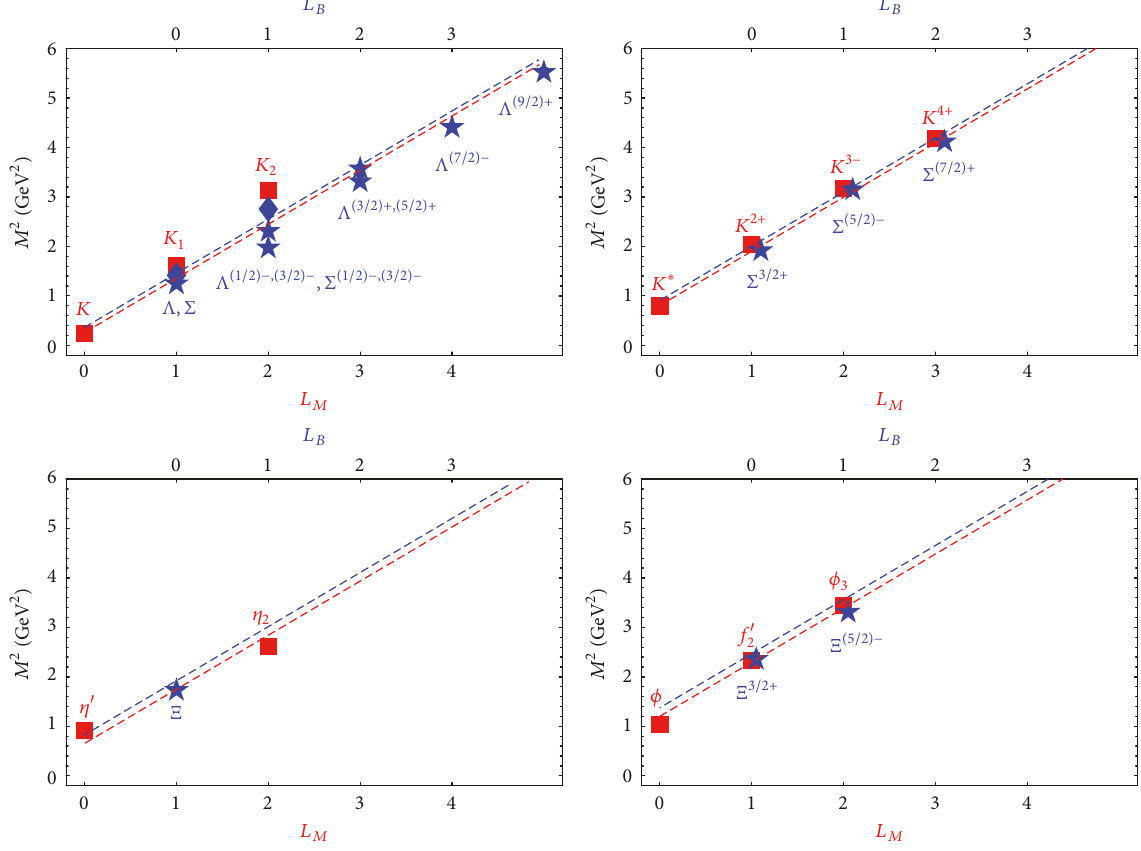
Figure 2: The 𝐾 , Λ ; 𝐾 ∗ , Σ ∗ ; 𝜂 耠 , Ξ ; and 𝜙 , Ξ ∗ trajectories, from